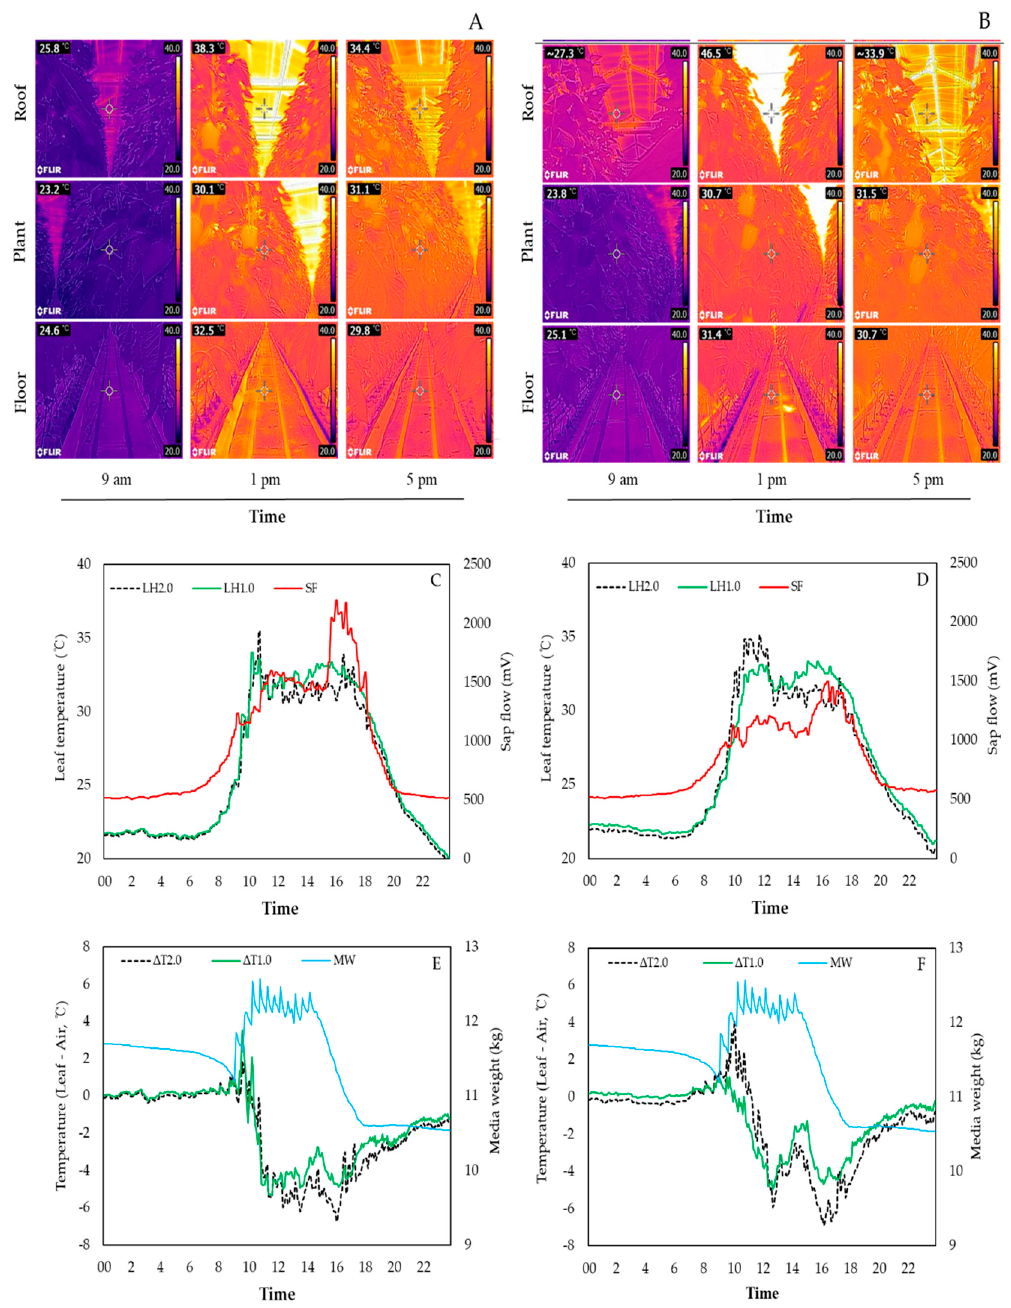
Figure 3. Temperature at different positions of greenhouse in S1 ( A ) and S2 ( B ) treatments. Leaf temperature and sap flow of S1 ( C ) and S2 ( D )-treated plants. LH2, 2 m height of plant; LH1, 1 m height of plant; SF, sap flow. The temperature difference between leaf and air in S1 ( E ) and S2 ( F ) treatments. Δ T2.0, 2 m height of plant; Δ T1.0, 1 m height of plant; MW, growing media weight.